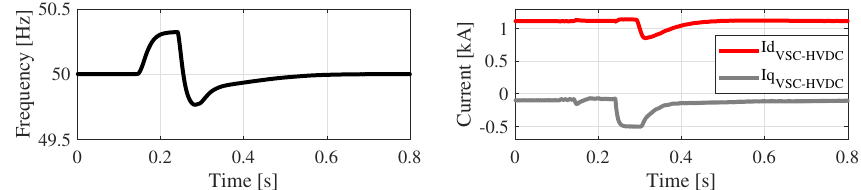
Figure 16. Offshore frequency ( left ) and currents ( right ) of VSC2 in the dq synchronous frame when a single-phase fault occurs in the HVAC